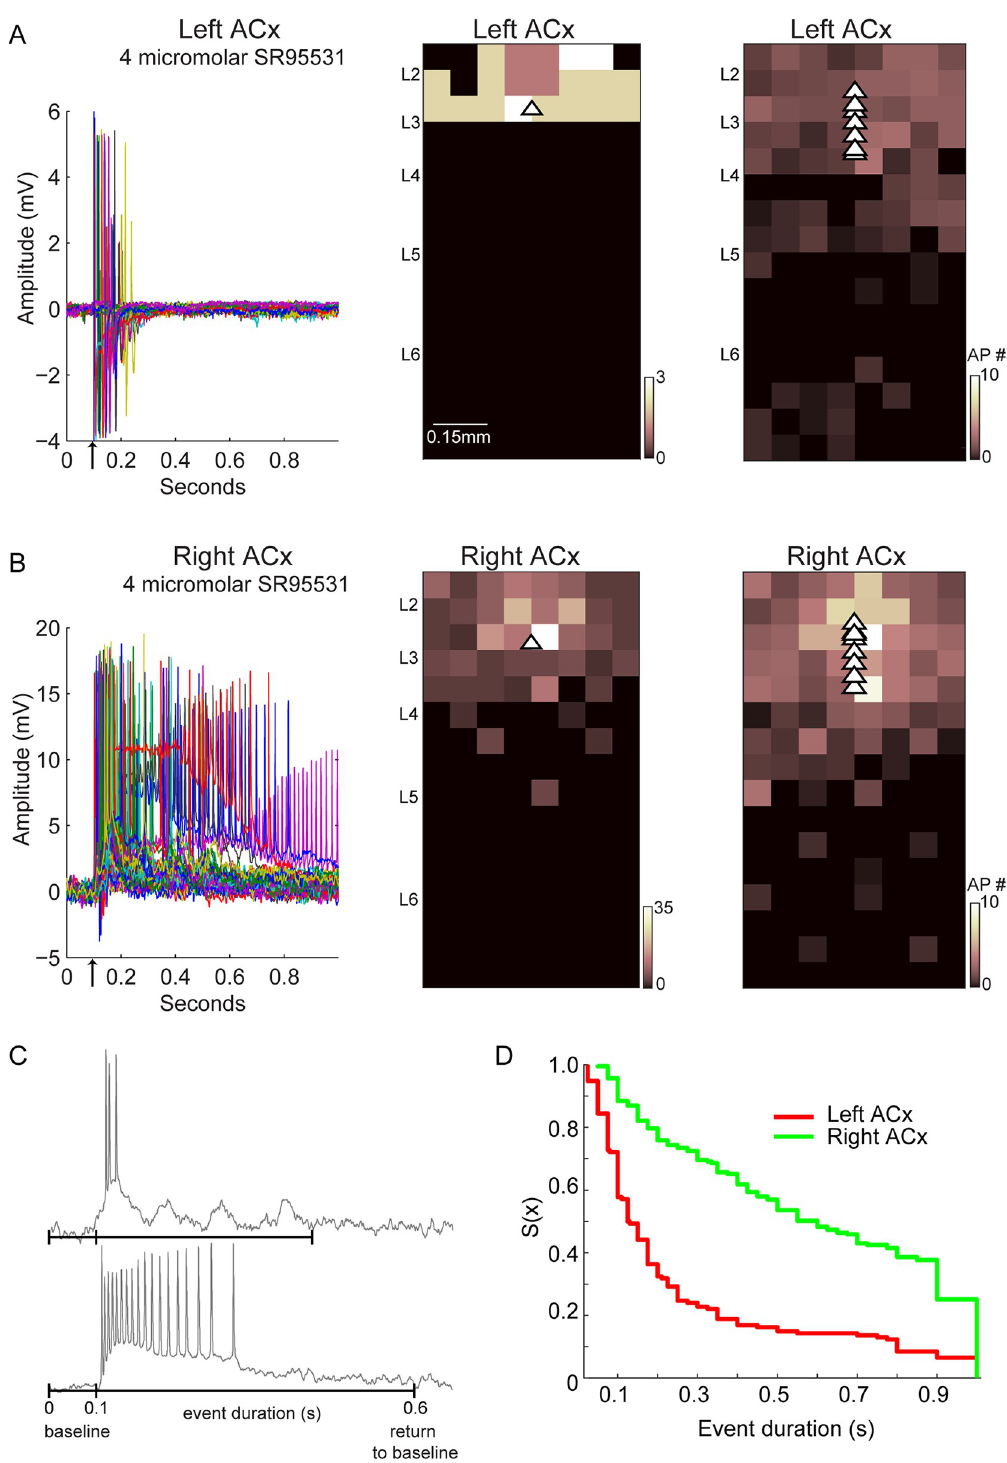
Fig 3. Stronger network events in the right ACx. (A, left) All traces of cell-attached recording from an L3 excitatory neuron in the left ACx with 4 μ m concentration of SR95531 in the bath. Black arrow on the x axis marks the onset of photostimulation. (A, middle) Map of action potentials evoked in the cell shown in the left panel and the population of cells recorded in the left ACx ( n = 8, right). Triangles show position of the cells recorded. (B, left and middle) Same experimental conditions as in A, but conducted in the right ACx of the same animal. (B, right) Population map of all cells recorded in